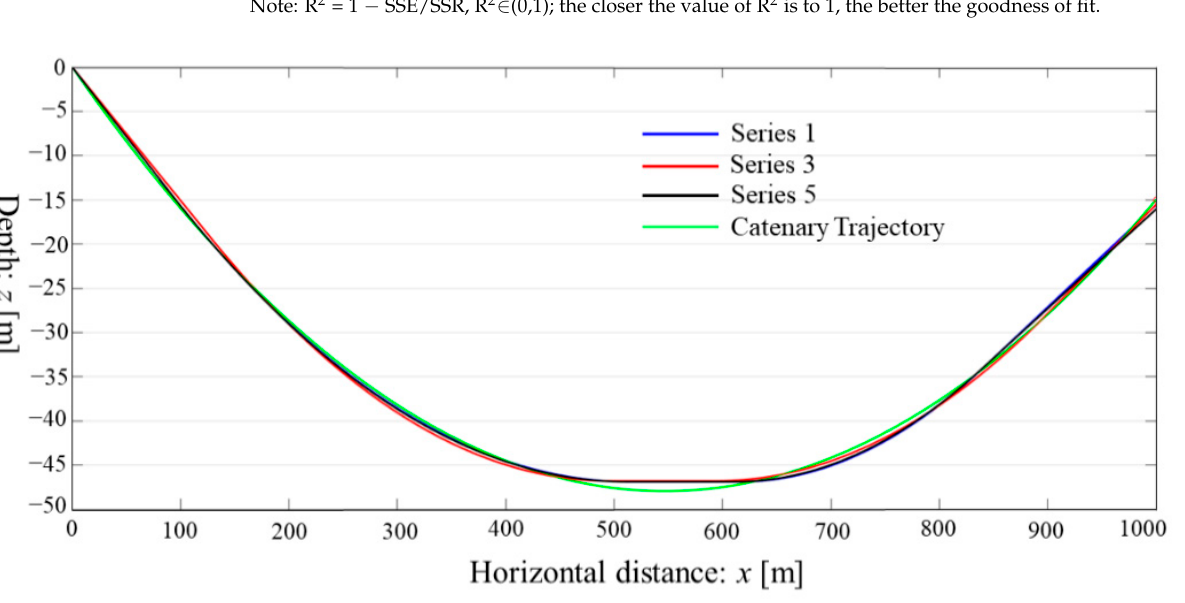
Table 2. Comparison of goodness of fit for different algorithm parameters.